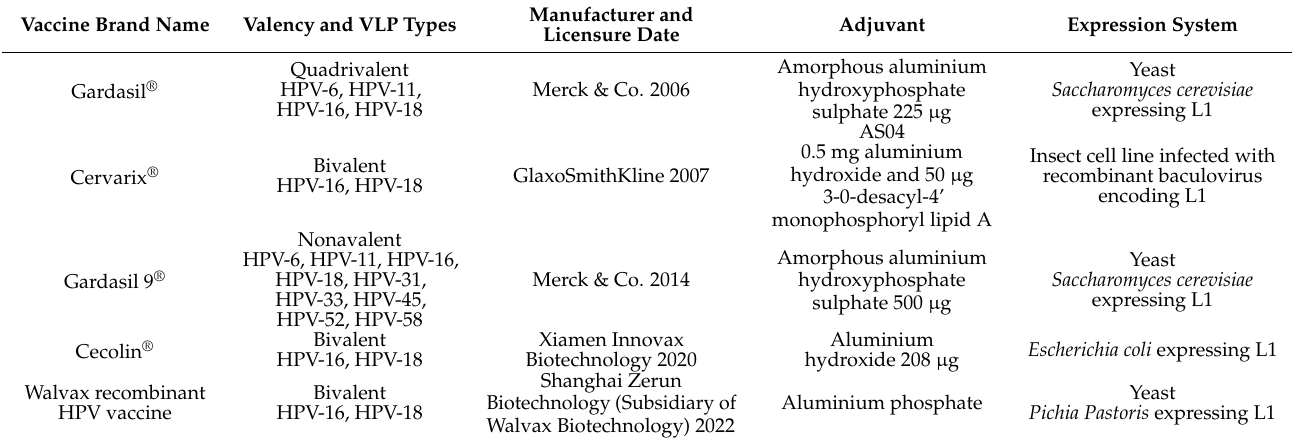
Table 1. Characteristics of currently licensed prophylactic HPV